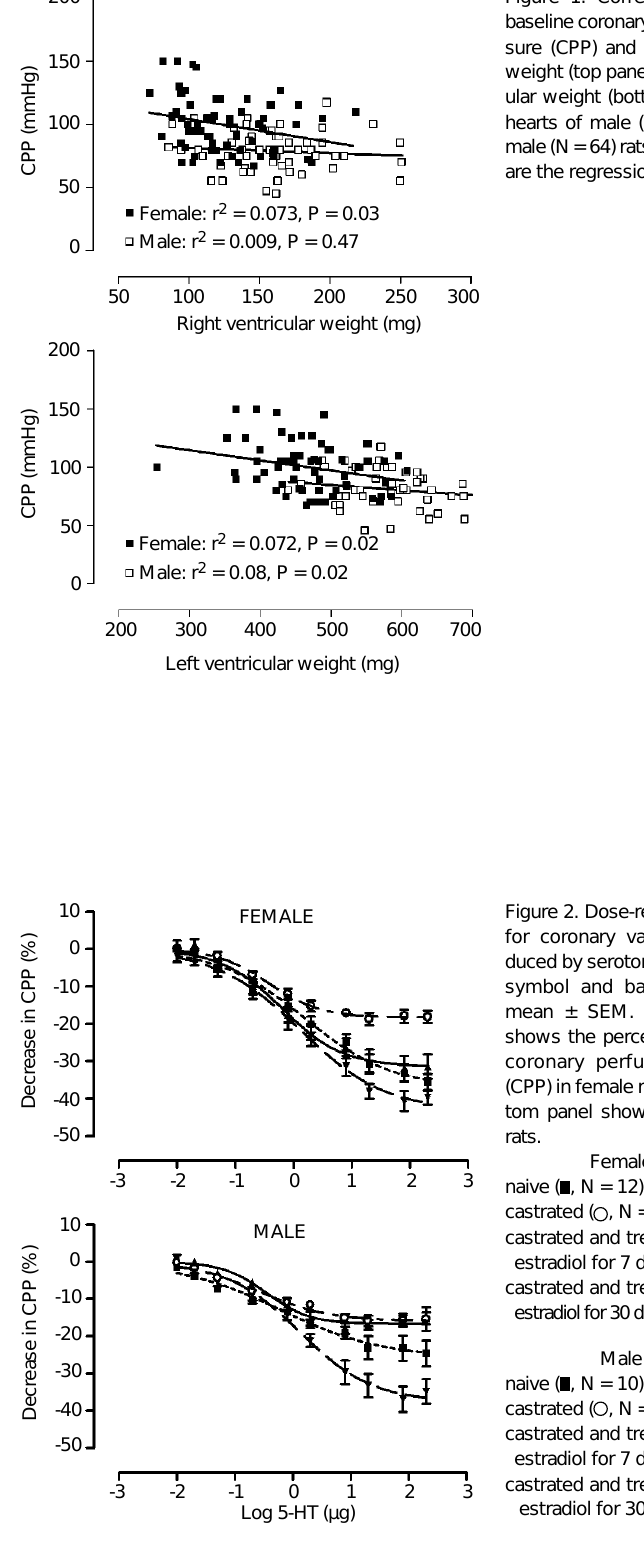
Figure 1. Correlation between baseline coronary perfusion pres- sure (CPP) and right ventricular weight (top panel) or left ventric- ular weight (bottom panel) from hearts of male (N = 58) and fe- male (N = 64) rats. The thick lines are the regression curves.